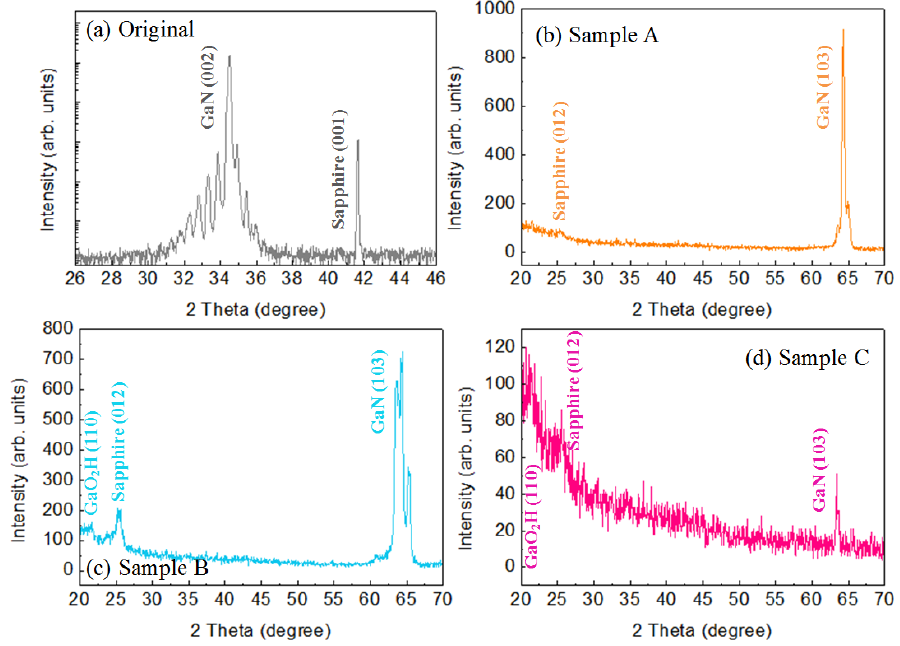
Figure 3. X-ray diffraction (XRD) spectra of GaN-epi/PSS with and without using substrate-reclamation process I.